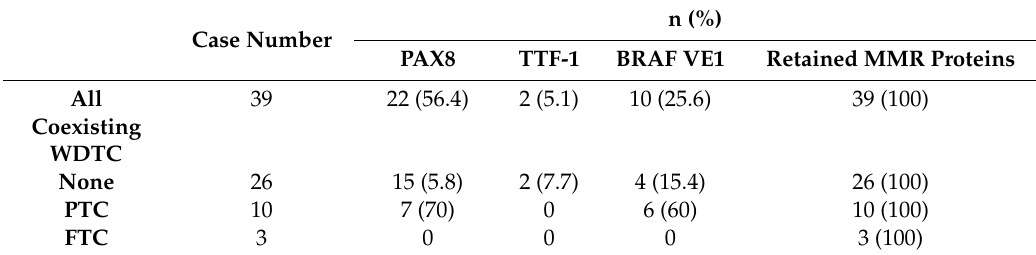
Table 2. Summary of the results of